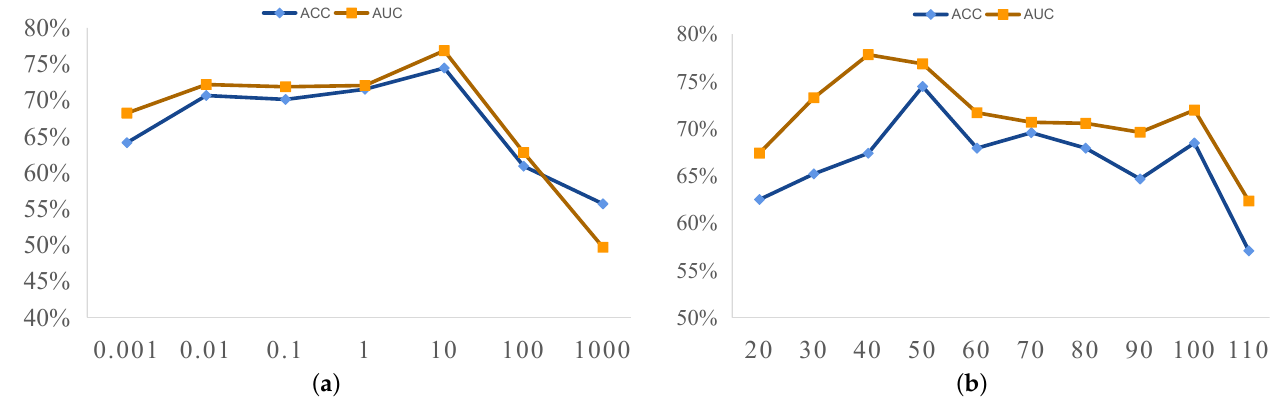
Figure 4. Classification results (ACC and AUC) of our proposed method according to different parameters based on a t -test with a p -value of 0.001. ( a ) Influence of the regularization parameter ( α ) on the model classification results; ( b ) effect of the embedding space dimension ( r ) on the model classification